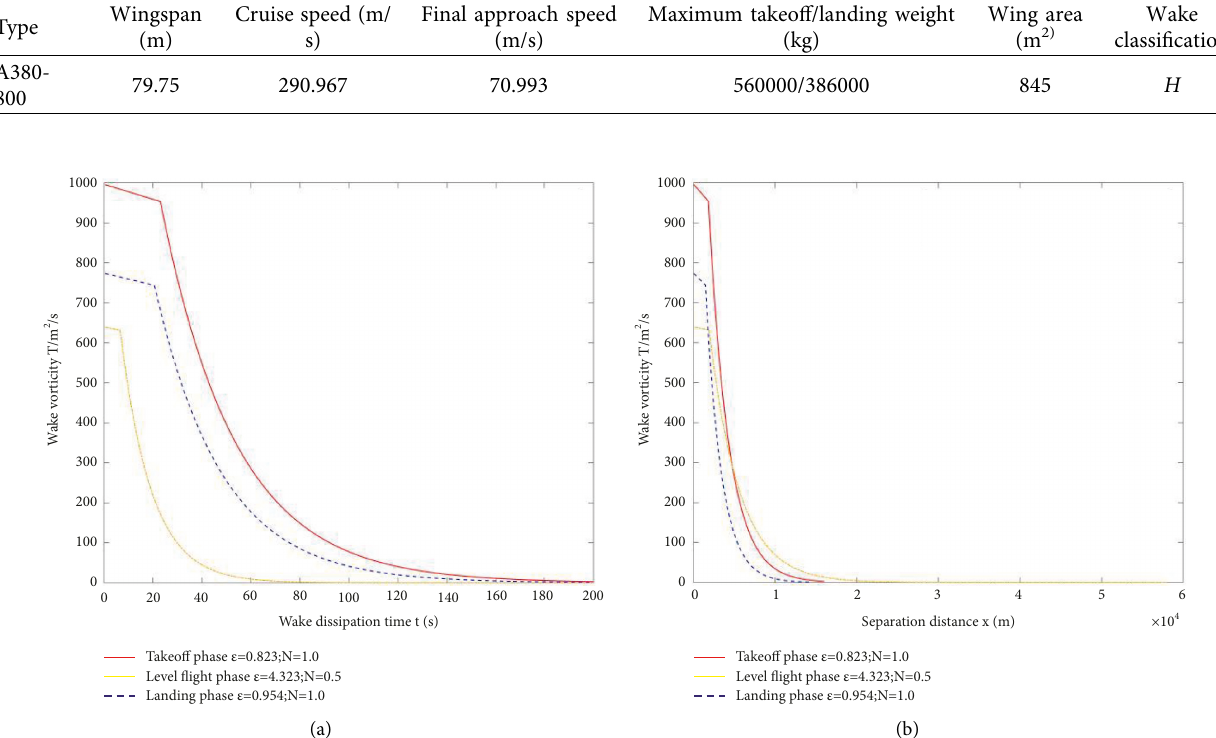
Figure 2: Variation of wake vorticity in different flight stages. (a) Circulation changes with time. (b) Circulation varies with separation distance.